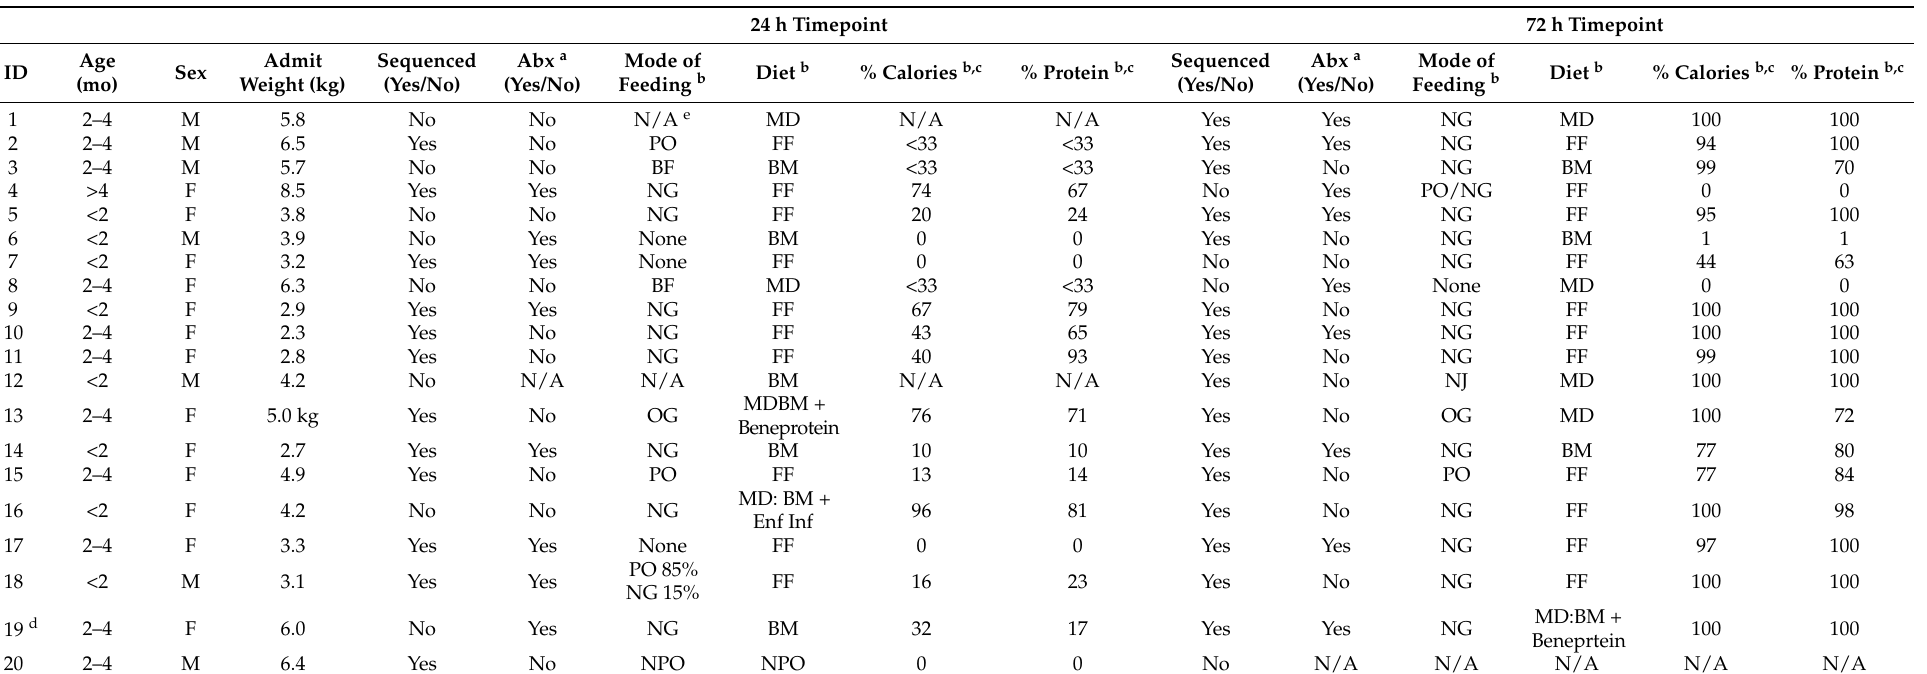
Table 1. PICU patient characteristics at 24 h (baseline) and 72